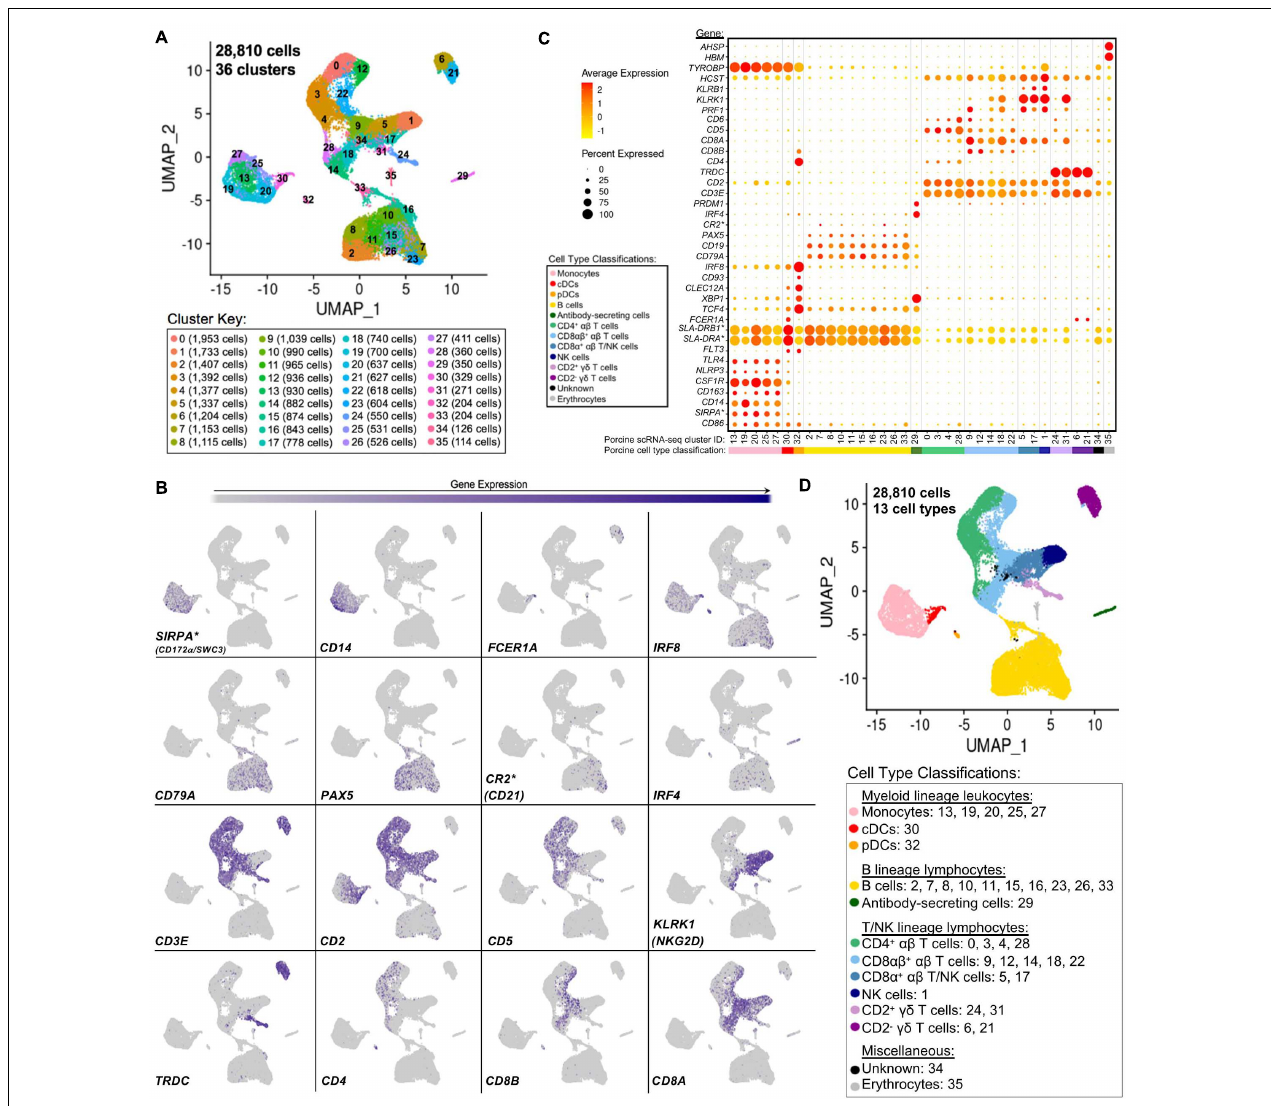
FIGURE 4 | Classification of porcine PBMC scRNA-seq clusters based on known cell type-specific gene expression. (A) Two-dimensional UMAP visualization of 28,810 single cells from porcine PBMCs classified into 36 designated clusters. Each point represents a single cell. Color of the point corresponds to transcriptional cluster a cell belongs to. Cells more transcriptionally similar to each other belong to the same cluster. (B) Visualization of selected cell type-specific gene expression overlaid onto two-dimensional UMAP coordinates of single cells. Each point represents a single cell. Color of the point corresponds to relative expression of a specified gene (bottom left of each UMAP plot) within a cell. Gray corresponds to little/no gene expression, while navy corresponds to increased gene expression. (C) Dot Plot visualization of selected cell type-specific gene expression for each single-cell cluster shown in A. Clusters are listed on the x -axis, while selected genes are listed on the y -axis. The size of a dot corresponds to the percent of cells in a cluster that expressed the gene. The color of a dot corresponds to the average relative expression level for the gene in the cells expressing the gene within a cluster. Color bar below the x -axis corresponds to porcine cell type each cluster was classified as. (D) Two-dimensional UMAP visualization of single cells from porcine PBMCs classified into major porcine cell types. Each point represents a single cell. Color of the cell corresponds to porcine cell type the respective cluster was designated as based on gene expression patterns for the cluster it belonged to in (C) . Seven PBMC samples used for scRNA-seq analysis were derived from each of three separate experiments (experiment B, n = 2; experiment C, n = 3; experiment D, n = 2). Between 3,042 and 6,518 cells were derived from each PBMC sample. *Refer to ‘Gene name replacement’